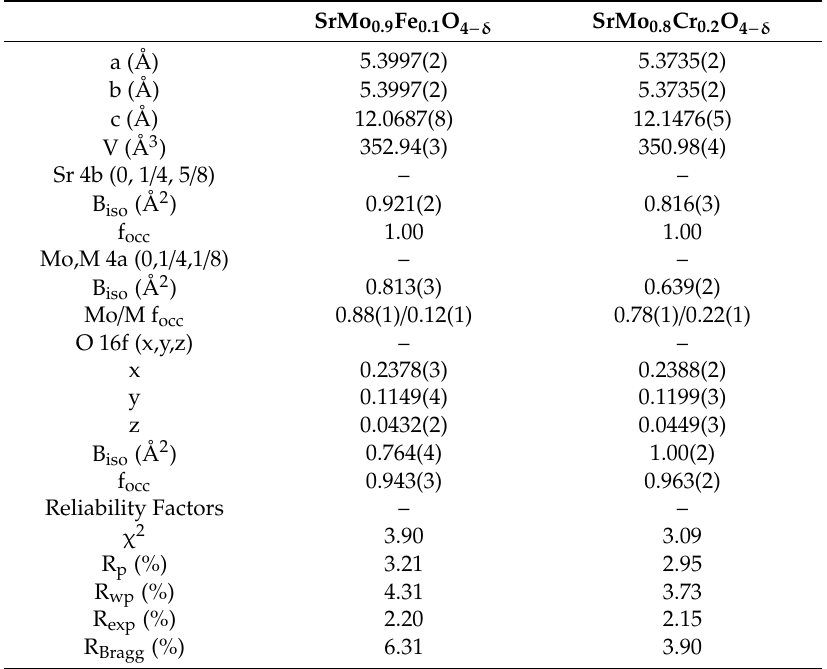
Table 1. Unit-cell, displacement parameters, interatomic distances, and angles for SrMo 1- x M x O 4 − δ in tetragonal I4 1 / a (No 88) space group, Z = 4, from NPD at 25 ◦ C. Sr is placed at 4 b (0, 1 / 4, 5 / 8); Mo, M at 4 a (0, 1 / 4, 1 / 8), and O at 16 f (x,y,z) sites.